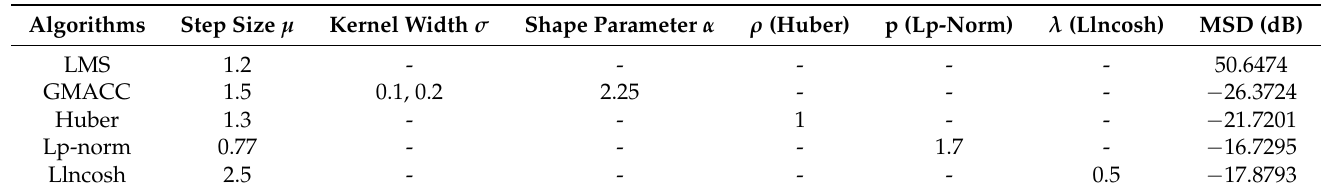
Figure 13. Performance comparison of GMACC, MACC and MCC algorithms with different shape parameters. Table 5. Parameters and steady-state MSD of the algorithms in simulation 5.